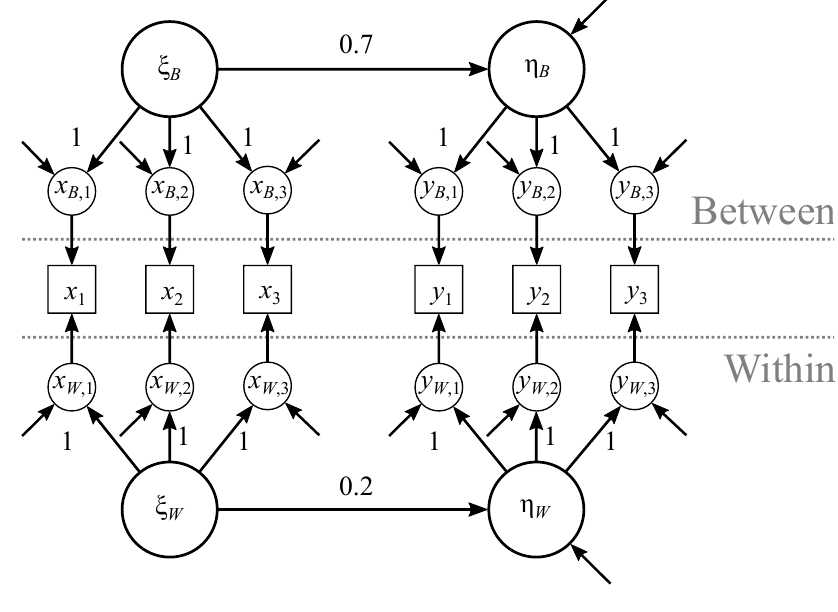
Figure 1. Data-generating